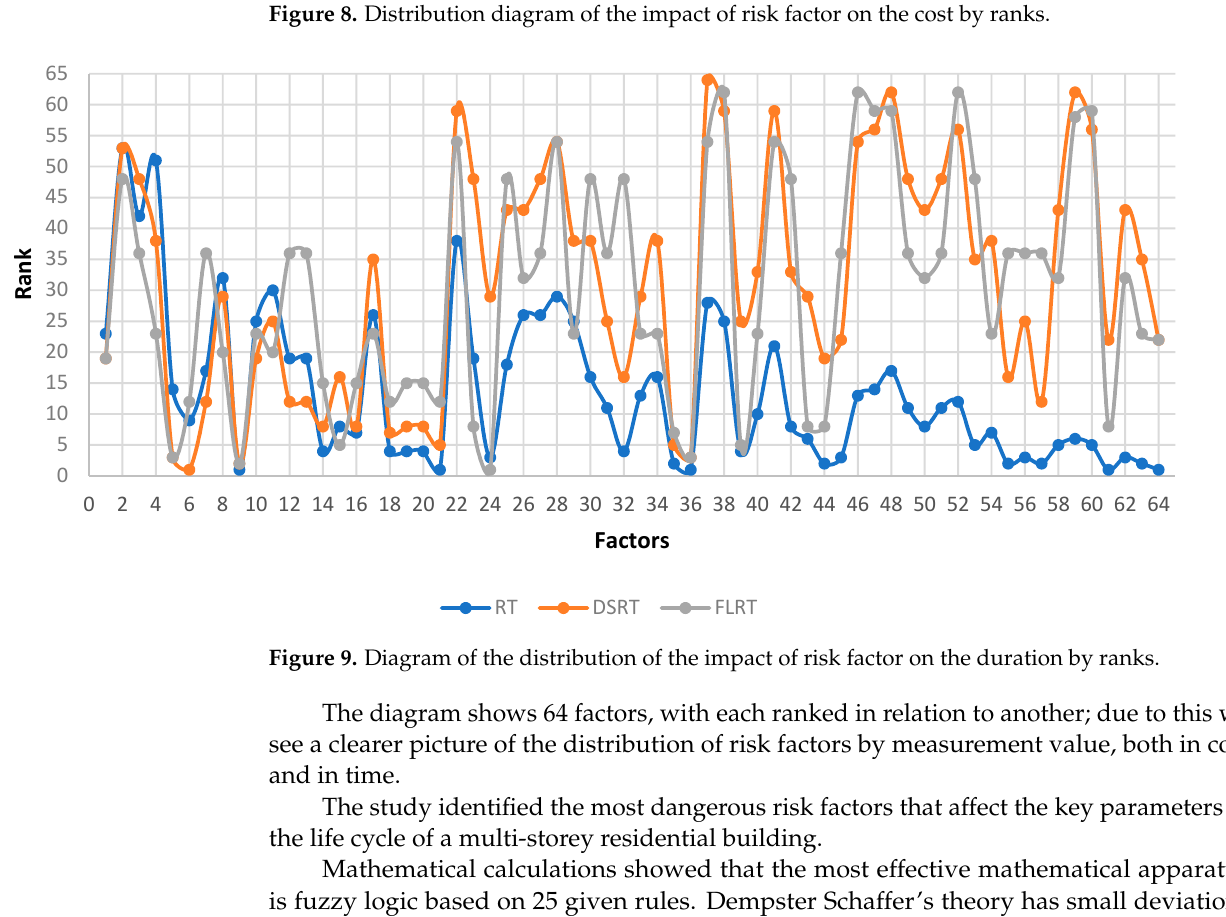
Figure 8. Distribution diagram of the impact of risk factor on the cost by ranks.